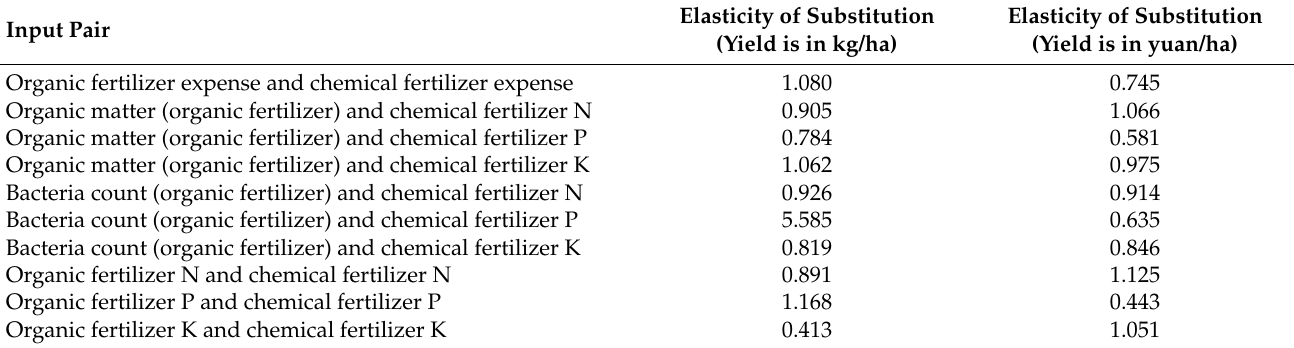
Table 6. Estimated mean values of direct elasticities of